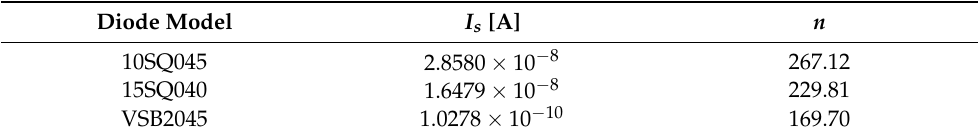
Table 8. Reverse bias ( D r ) curve fitting parameters for the three diodes.